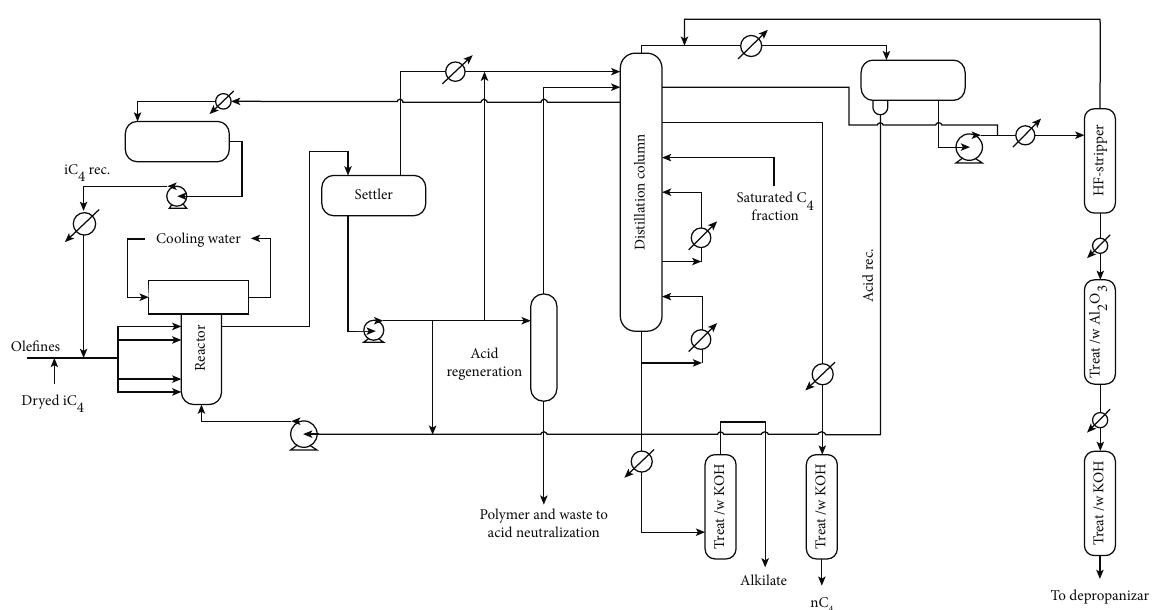
Figure 22: Process flow diagram of the hydrofluoric acid (HF) alkylation production unit.